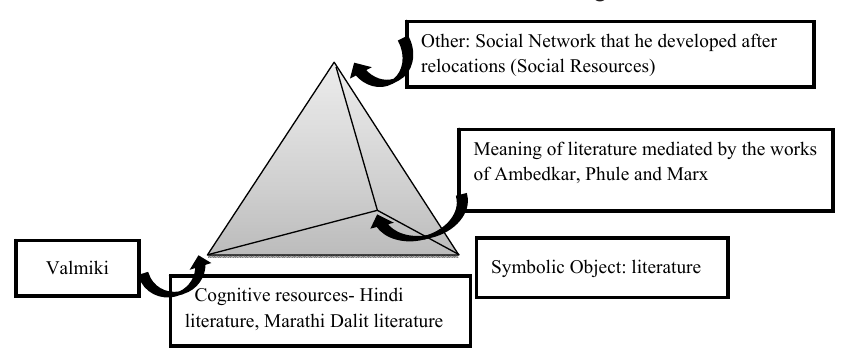
Fig. 2: Reconfigured Semiotic Prism Followed by Relocations The essence of the symbolic resources was not lost in the process of creation but utilized by Valmiki at the ‘reflective’ level of reflexivity. Rather, the capability of distancing was eased by the works of Ambedkar, Phule, and Marx. Beyond the immediate cultural value of symbolic resources, he created characters on the plane of fiction. That’s why his characters are infused with Dalit consciousness even without making any direct reference to the ideas of anti-caste intellectuals. His stories are inscribed in time as they connect past with the present and weave the realities and subtleties of caste in the village and city simultaneously. Significance of their creation lies in the fact that even the fictional characters are portrayed against the reality of the caste-ridden Indian